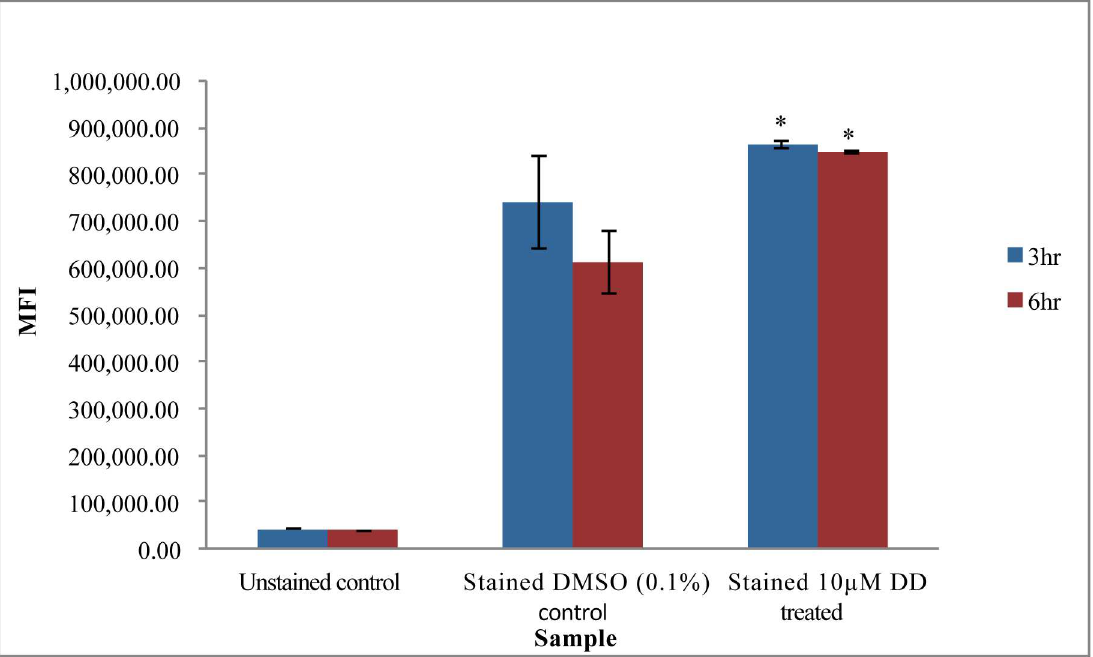
Fig 3. Neutral lipids as quantified by Bodipy dye (505/515). Error bars represent standarderror between three biological replicates( * p < 0.05with respect to DMSO solvent control). The data are representativeof two independent experiments. bodipy and assayed by flow cytometry to quantify neutral lipids. DD treated cells significantly accumulated 1.16 and 1.38 fold neutral lipids compared to DMSO control at 3 and 6 hr, respectively (Fig 3).